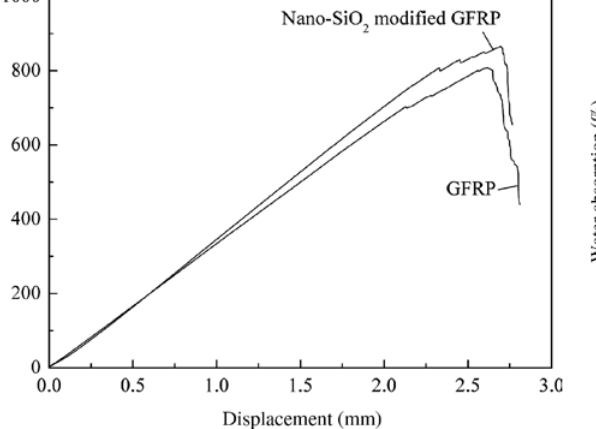
Figure 6: Water absorption as a function of the immersion time for the GFRP